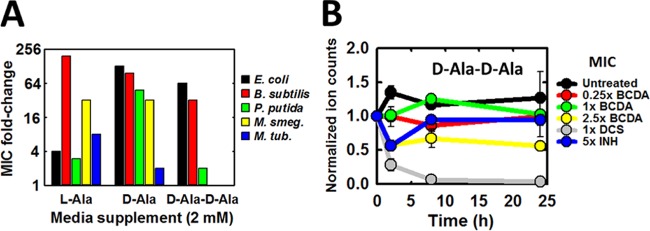
BCDA does not inhibit the d-alanine pathway in M. tuberculosis. (A) Fold increase in BCDA MIC relative to levels seen with unsupplemented control cultures in various bacterial species following growth medium supplementation with 2 mM l-Ala, d-Ala, or d-Ala-d-Ala. MICs were read 10 days following initial culture inoculation for H37Rv, 24 h following initial culture inoculation for E. coli, B. subtilis, and P. putida, and 48 h following initial culture inoculation for M. smegmatis (M. smegmatis). M. tub., M. tuberculosis. (B) Intracellular levels of d-Ala-d-Ala in H37Rv across 24 h of exposure to various test compounds (as indicated). Data for DCS and INH are taken from reference 5. Plots represent the averages ± SEM of data from duplicate experiments. See also Fig. S2 in the supplemental material.